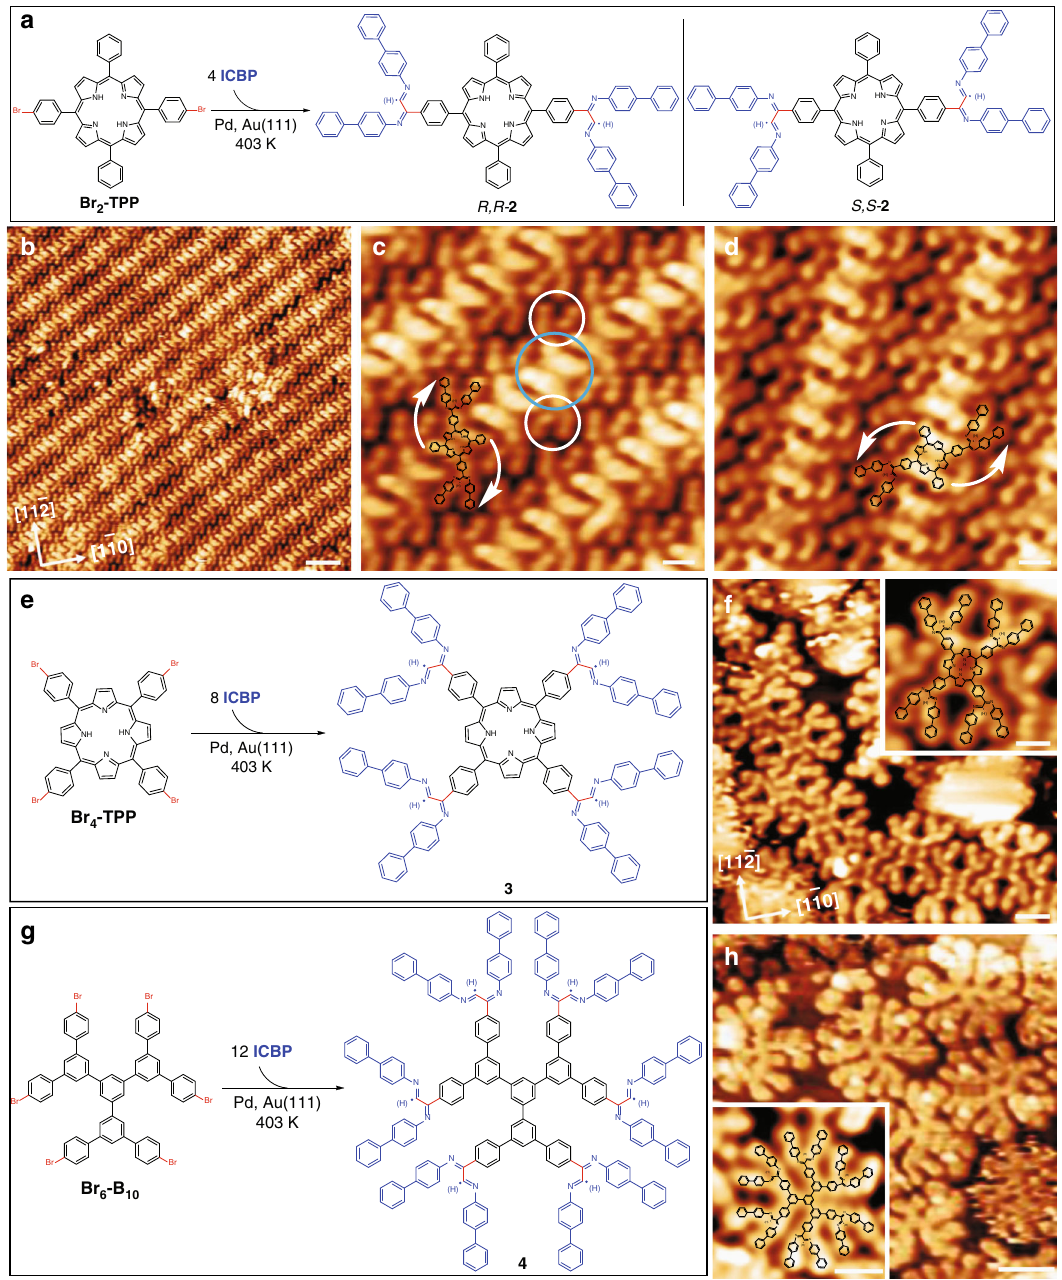
Fig. 5 On-surface synthesis of planar dendron and dendrimers. a Schematic representation of DCR used to generate dendrons R , R - 2 and S,S - 2 . b STM image of self-assembled dendron 2 on Au(111). c STM image of self-assembled dendron R,R - 2 . d STM image of self-assembled dendron S,S - 2 . e Schematic representation of DCR used to generate dendrimer 3 on Au(111). f STM image of dendrimer 3 . The inset represents a close-up image of a single dendrimer 3 . g Schematic representation of DCR used to generate dendrimer 4 on Au(111). h STM image of dendrimer 4 . The inset represents a close-up image of a single dendrimer 4 . The dendron 2 , dendrimers 3 and 4 might be surface-bonded radicals or hydrogenated species. Scale bars: b 3nm. c , d and inset of ( f , h ) 1nm. f 2nm. h 2nm. Tunneling parameters. b , c I = − 0.11nA, U = − 1.80V. d I = − 0.17nA, U = − 1.67V. f I = − 0.52nA, U = − 1.52V. h I = 0.49nA, U =